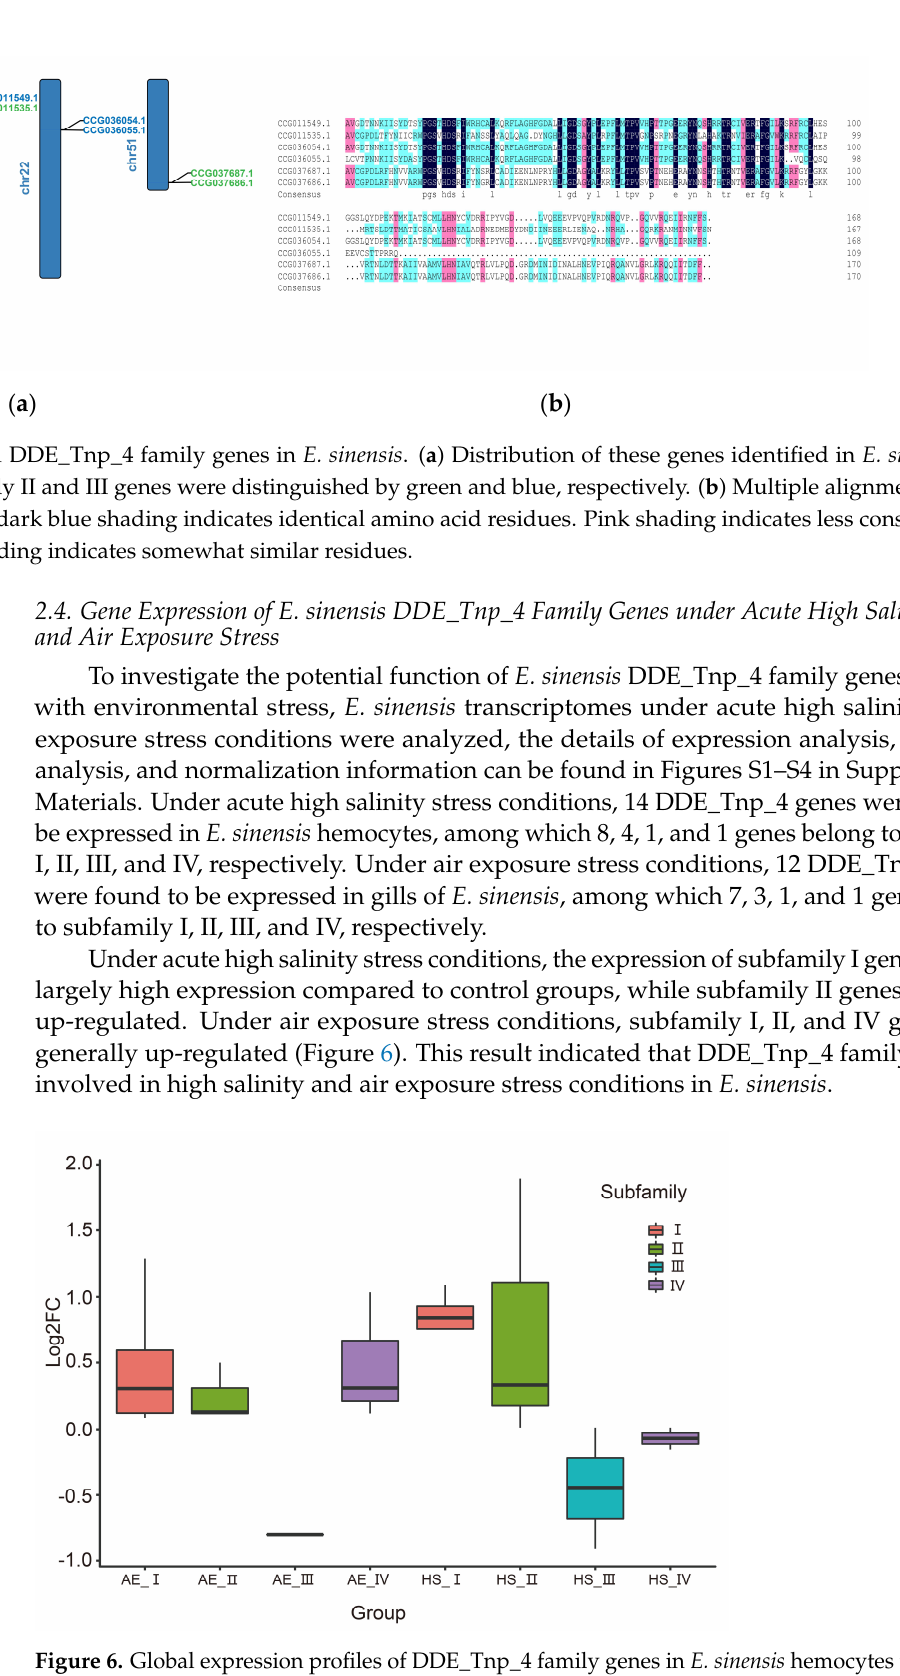
Figure 6. Global expression profiles of DDE_Tnp_4 family genes in E. sinensis hemocytes under acute high salinity conditions and in E. sinensis gills under air exposure stress conditions. represents respective subfamily genes under air exposure stress conditions. HS_I-HS_IV represents respective subfamily genes under acute high salinity stress